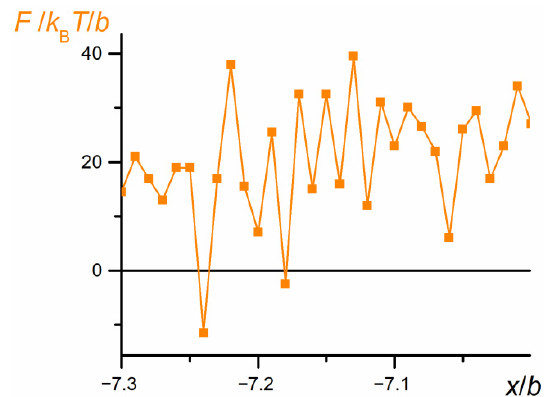
Figure 19. The average force, F , exerted by part P2 on P1 of the chain observed for a very short time period vs. the x coordinate of the chain mass center ( N = 100, ε PP / k B T = − 1 and 0 for P1 and P2, respectively, D = 3 b ). The chart is based on the data recorded at each elementary step, t E .